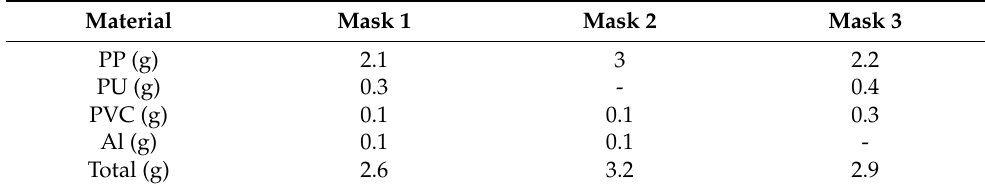
Table 1. Weights of material components of masks. Values are reported in